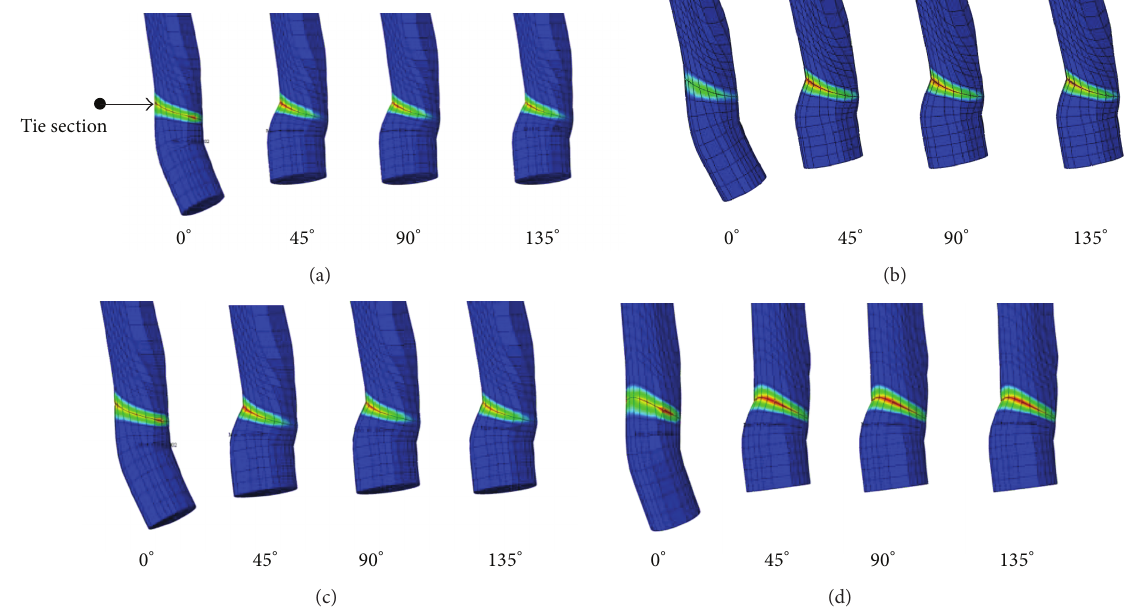
Figure 12: Reaction force simulation result for the tied sections of the models: (a) Method 1, (b) Method 2, (c) Method 3, and (d) Method 4.